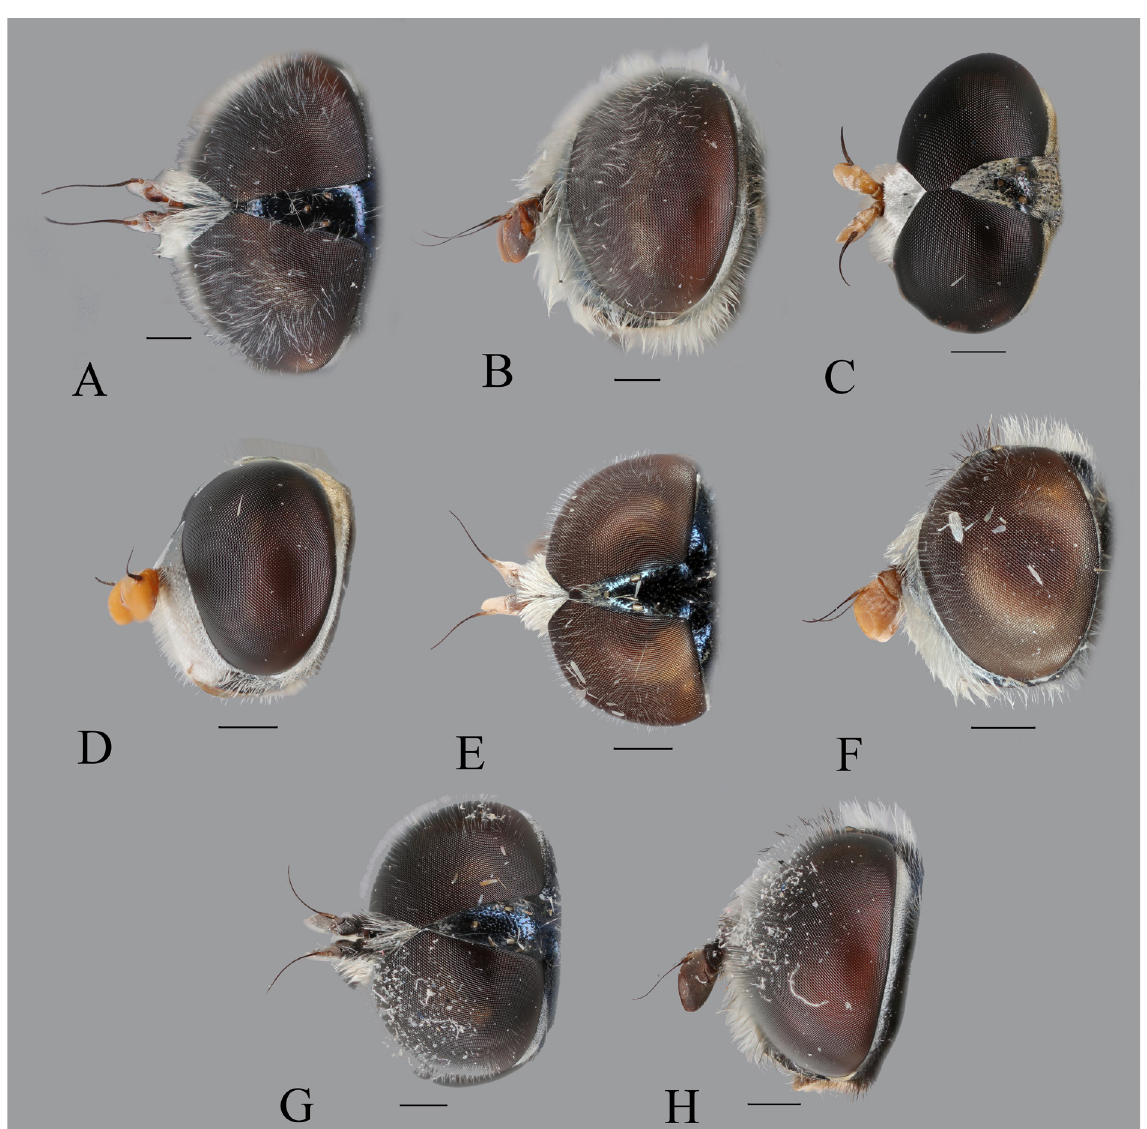
Fig. 15. Head, ♂, dorsal view (A, C, E, G) and lateral view (B, D, F, H). A–B . Eumerus coeruleus (Becker, 1913), Chekab Valley, Iran (JSA). C–D . E. jacobsoni Becker, 1913, Chekab Valley, Iran (JSA). E–F . E. kazanovzkyae Paramonov, 1927, Paveh, Iran (HMIM). G–H . E. longitarsis Peck, 1979, Chekab Valley, Iran (JSA). Scale bars = 0.5